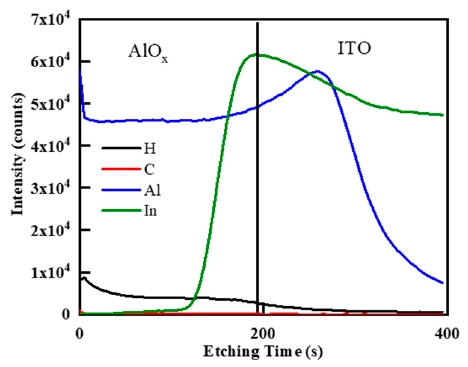
Figure 4. Distribution of H, C, Al, and In elements for the sample of AlO x film deposited on ITO surface with water treatment and 350 °C annealing analyzed by TOF-SIMS.